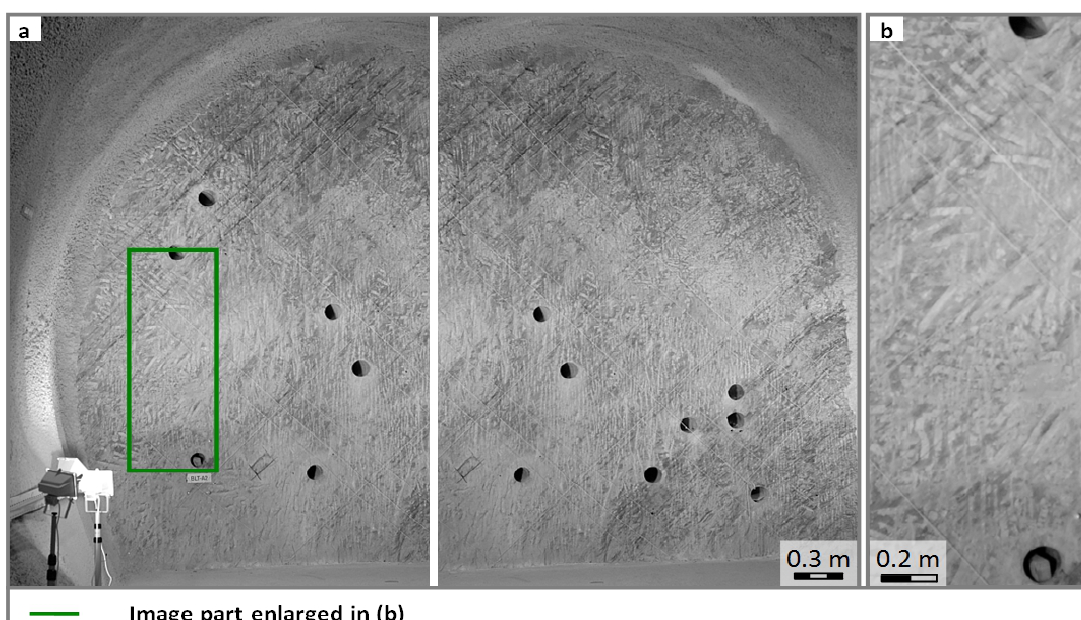
Figure 5. ( a ) Nikon D200 images covering the TT Niche tunnel face, converted to grayscale; ( b ) Area corresponding to Figure